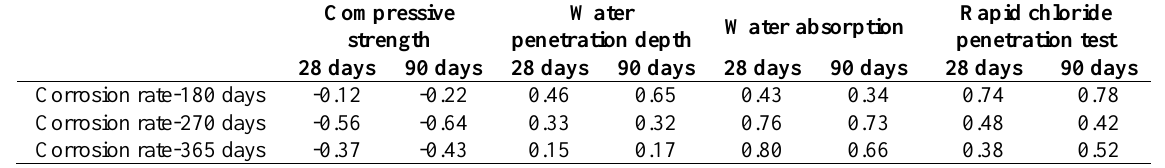
Table 8. Correlation between corrosion rate and the measured strength and transport properties Compressive strength